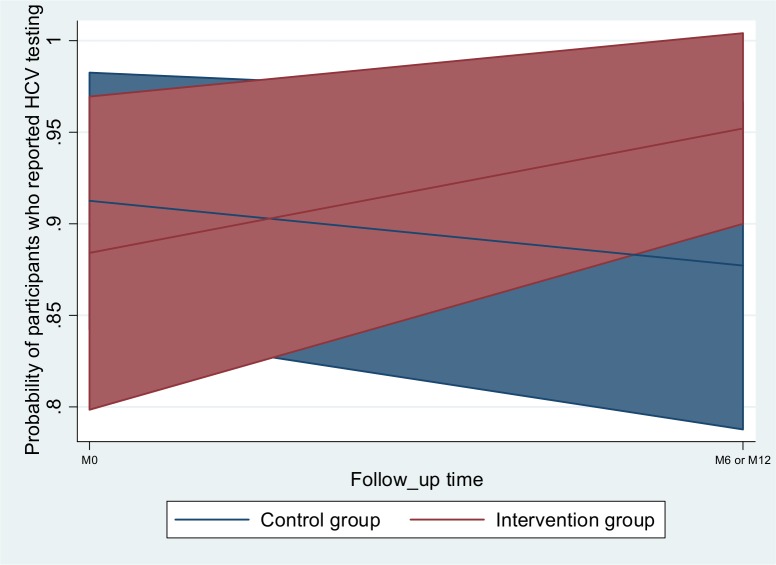
Predictive margins.